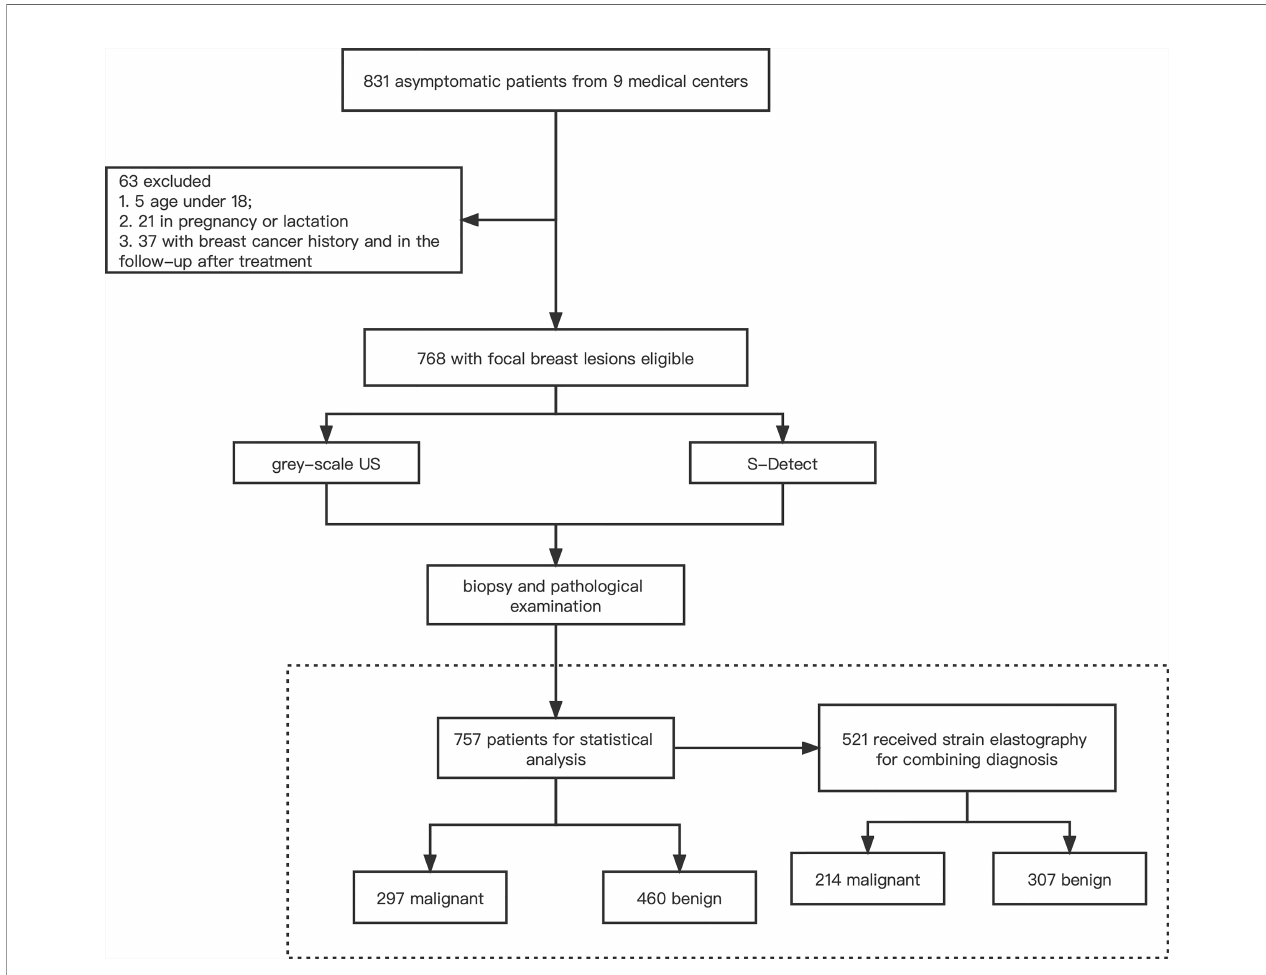
FIGURE 1 | The schematic of the study fl